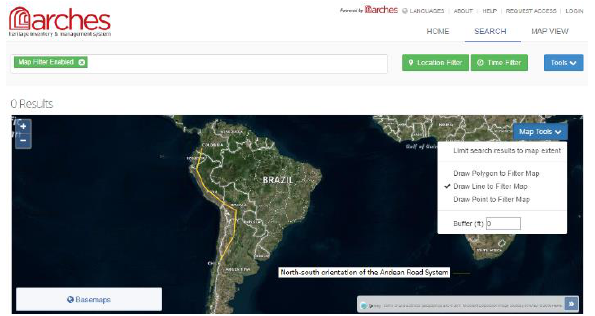
Figure 7. Protected Areas in the Provinces of Argentina that integrate the Andean Road System. © Instituto Geográfico Nacional, 2016. Base de Datos Geográfica. Visor SIG.